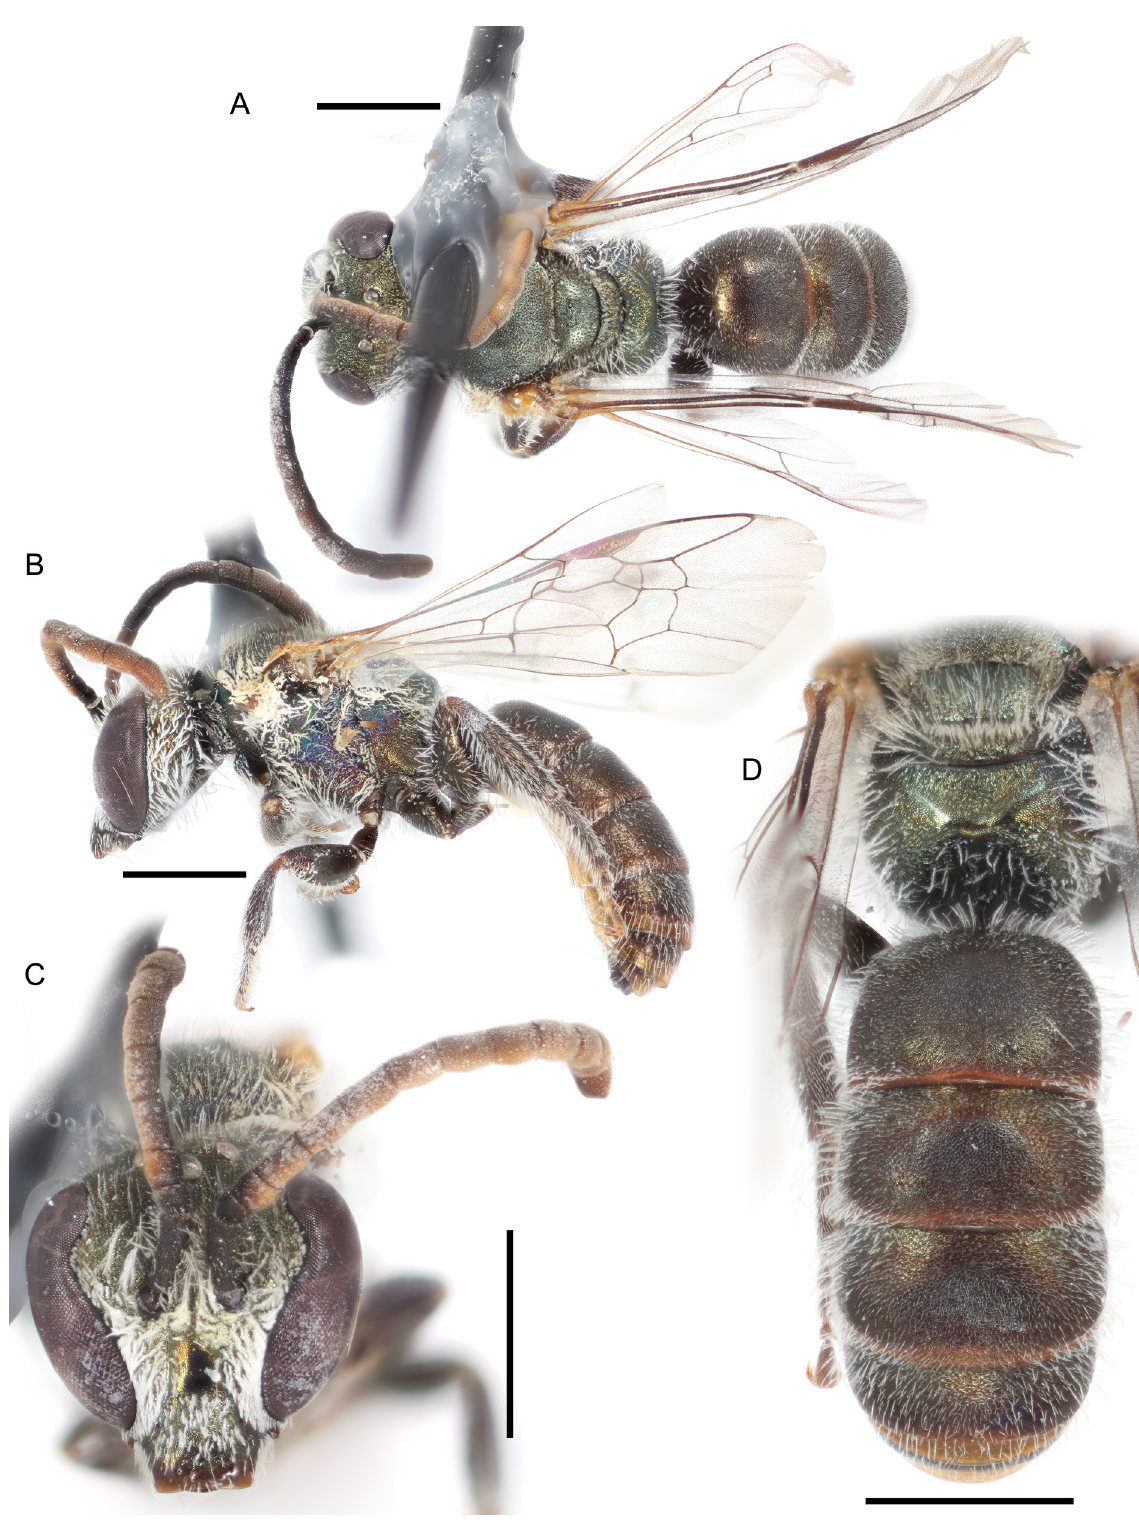
Fig. 34. Lasioglossum ( D. ) droegei Gibbs, 2009, ♂. A . Dorsal habitus. B . Lateral habitus. C . Face. D . Propodeum and metasoma. Scale bars: 1